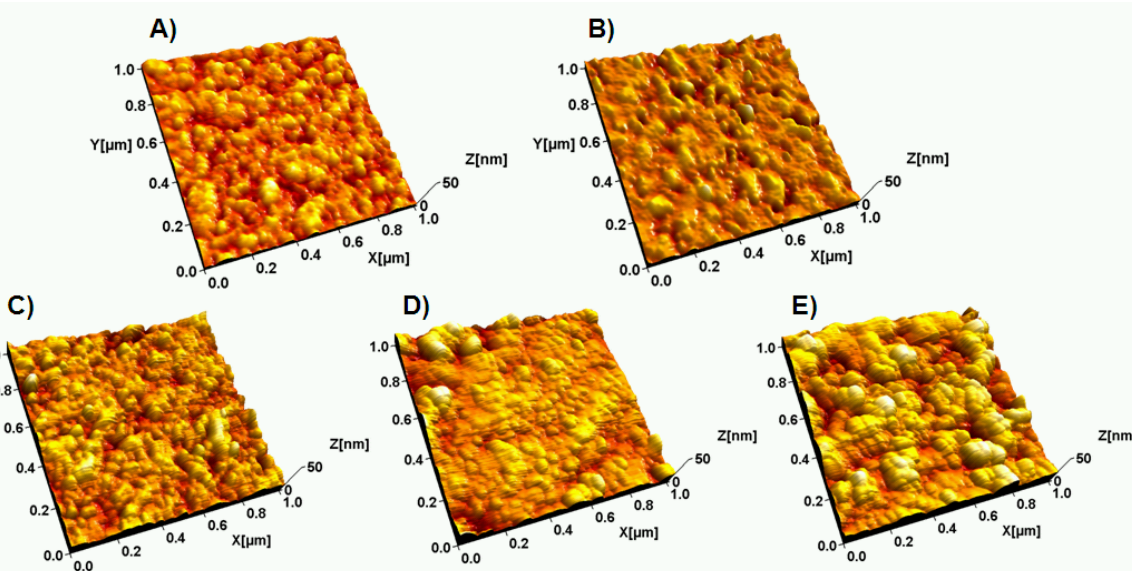
Figure 5. Atomic force microscopy (AFM) topographic images of ( A ) pristine gold